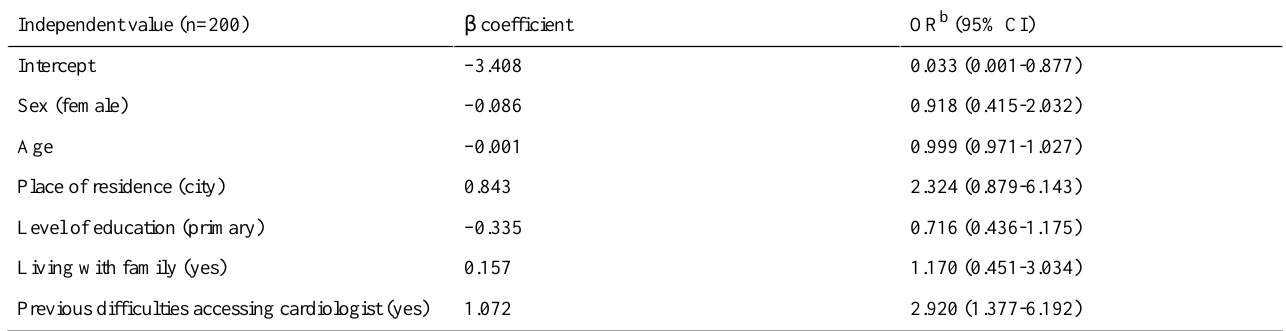
Table 5. Multivariate analysis between declared lack of acceptance of voice technology combined with provider-driven phone support and particular independent values a